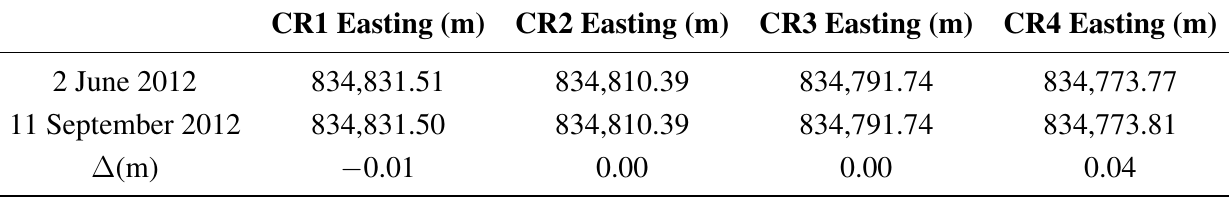
Table 3. CRs’ reference mark coordinates in the east-west direction at the beginning and ending of the validation